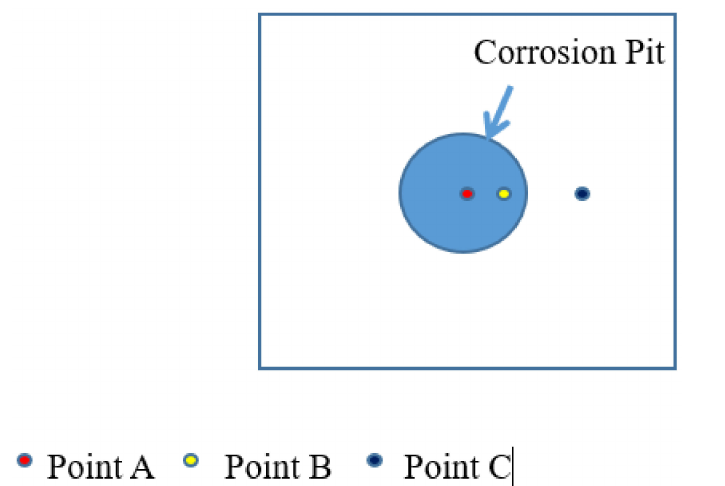
Figure 14. Illustration of Points A, B, and C.